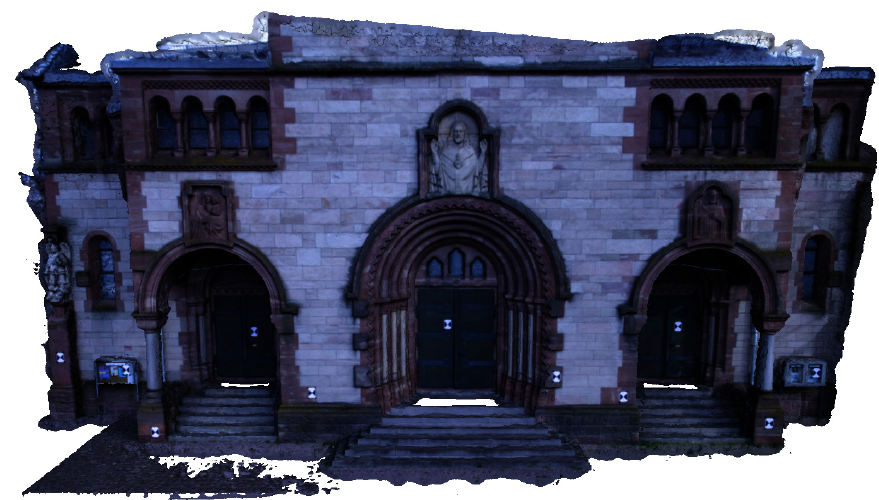
Figure 19. Texture model of Herz-Jesu-P25 sequence.